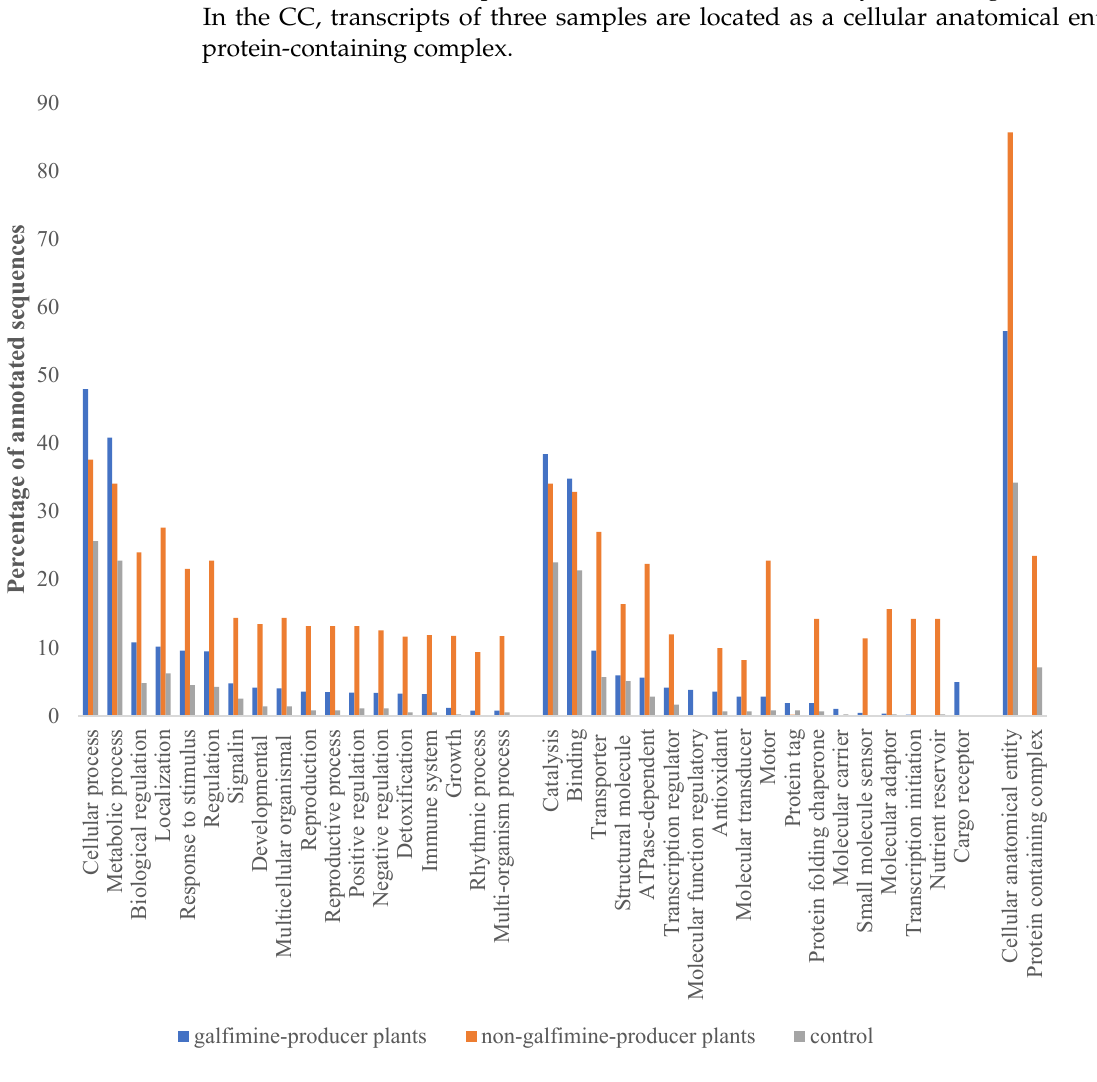
Figure 1. Percentage of annotated sequences of galphimine-producer plants (leaves samples, non- galphimine producer plants, (leaves samples) and control (roots samples) in gene ontology levels Biological Process (BP), Molecular Function (MF), and Cellular Component (CC).